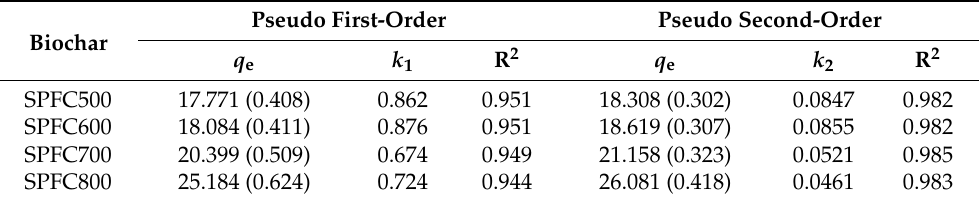
Table 2. The parameters obtained by fitting with adsorption kinetic equation.